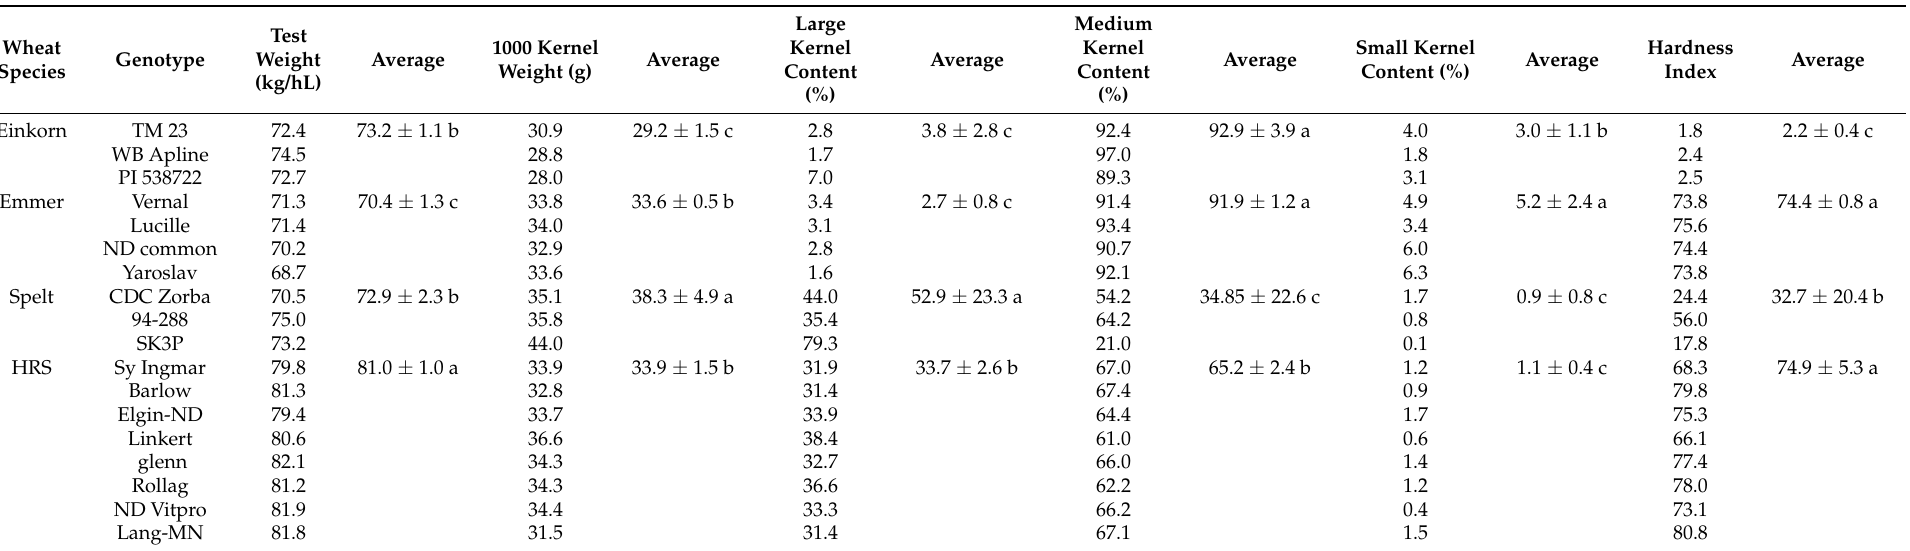
Table 1. Kernel quality traits of einkorn, emmer, spelt and hard red spring